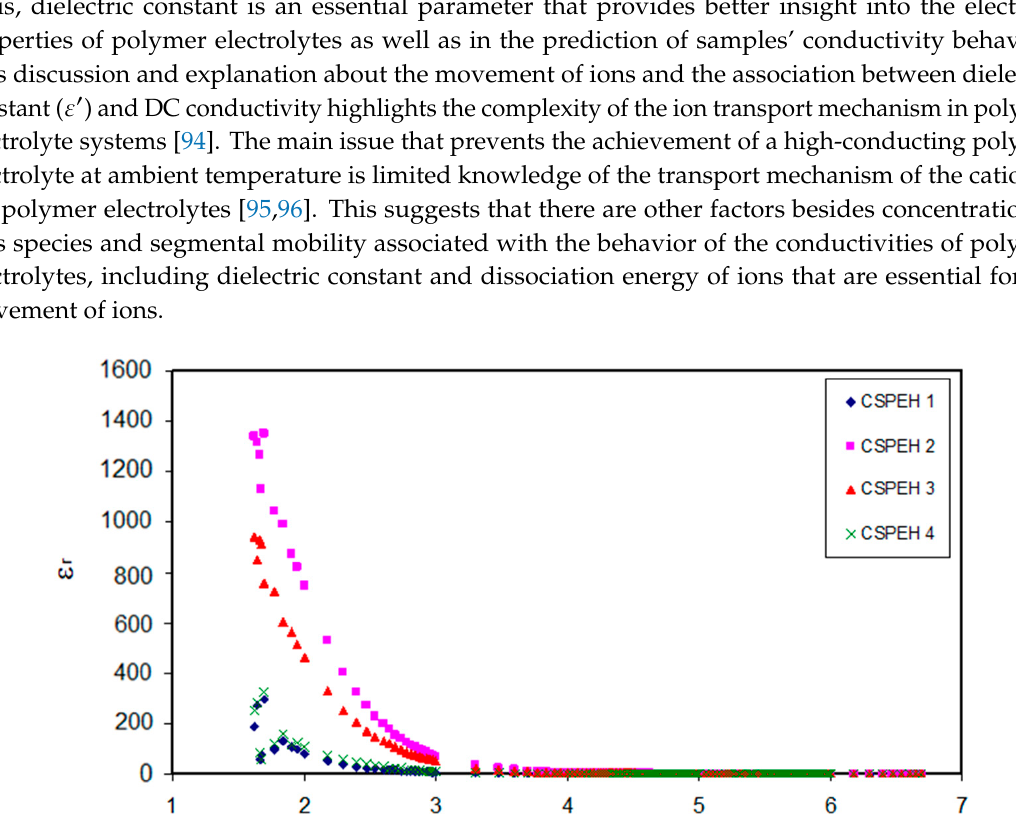
Figure 7. Dielectric loss in opposition to frequency logarithmic scale for all the electrolytes. 3.5. Electric Modulus Study Electrical modulus formalism can be helpful in conducting further research related to the dielectric performance. The modulus can be easily shown by repressing the signal intensity associated with electrode polarization or by focusing on little details in the high-frequency region [97]. Hence, the conductivity and the relaxation associated with conductivity in ionic conductors as well as polymers can be conveniently studied with the help of the electric modulus curves [8]. The issues that impeded the complete analysis and detailed permittivity relaxation including electrode nature, space charge mechanism and conduction impacts can be addressed [55,92,98,99]. The formulas given below allow the calculation of the real and imaginary parts of complex electric modulus (M*) by inserting the values of the real (Z r ) and imaginary (Z i ) parts of complex impedance (Z*) [55,82]: